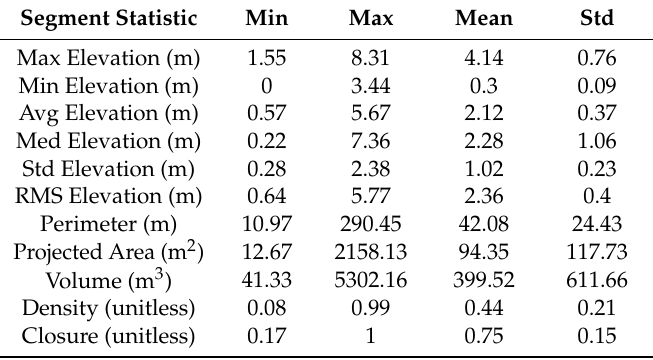
Table 1. Summary of the clumped segmentation statistics generated from the full 3D point cloud for all of the canopy objects within the analysis extent. Abbreviations: Standard Deviation (Std), Average (Avg).